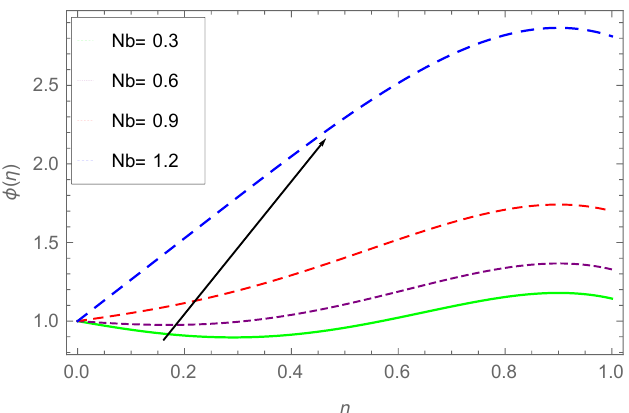
Figure 13. Impact of Nb on φ ( η ) , for St = 0.1, Nt = 0.1, Sc = 0.5, and β =